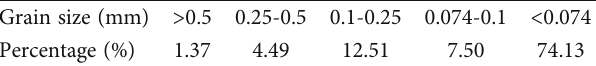
Figure 1: Schematic of the test system. Table 1: Soil particle